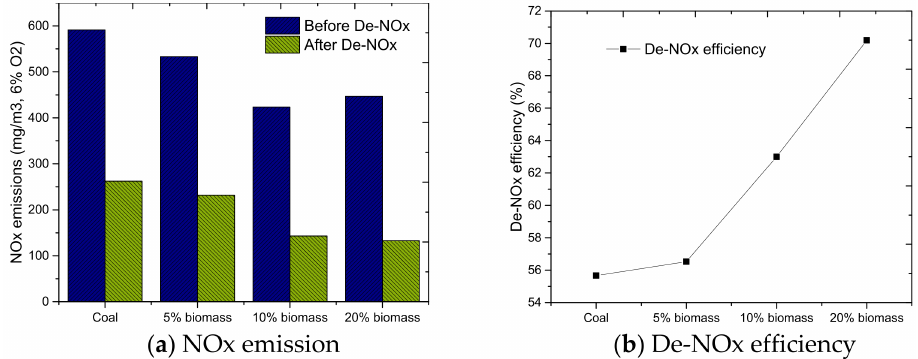
Figure 6. Effect of biomass co-firing on ( a ) NO x emission and ( b ) de-NO x